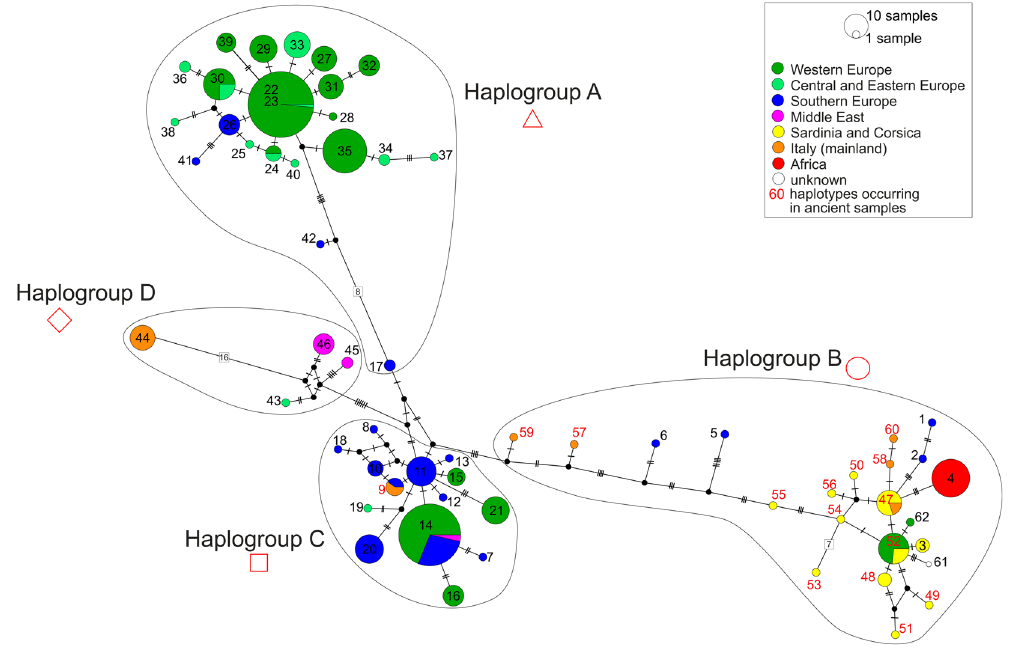
Figure 4. Median-joining haplotype network constructed in PopART. Haplotypes are represented by circles whose sizes are proportional to the number of individuals. Different colours represent geographic distribution. Haplotypes occurring in ancient samples are marked by red numbers. Less than seven mutational steps between haplotypes are indicated by hatch marks; more than seven are indicated by numbers at branches. Missing haplotypes are indicated by small black circles.